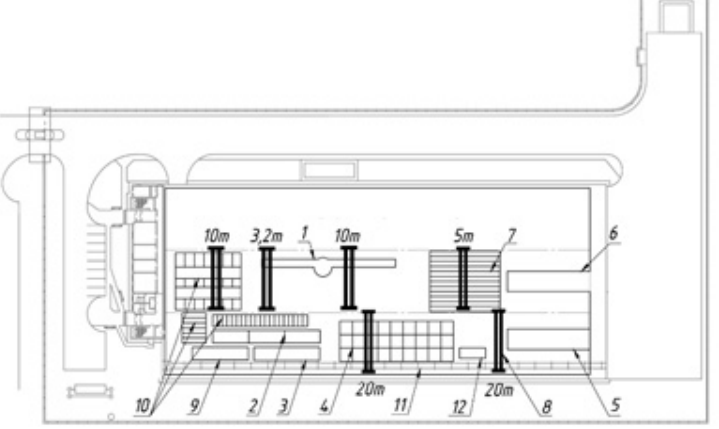
Figure 7. Layout of workstations in the analyzed enterprise (1. Production line of welded steel pipes (MTM—Tube Mills Machinery); 2. Lines for slitting the tapes; 3. Area for unpacking steel strip rolls; 4. Place of storage of steel strip rolls; 5. Raw materials unloading area; 6. The zone for loading finished products; 7. Warehouse of finished products; 8. Radio-controlled crane; 9. Waste containers (generated when removing the packaging); 10. Racks for storing cut strips circles; 11. Railway tracks; 12. Metal waste containers).